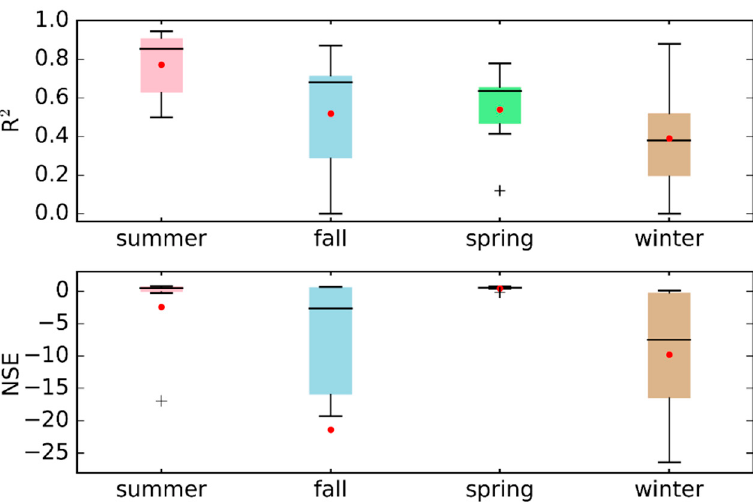
Figure 5. Seasonal NSE and R 2 for the Root River Basin for the calibration period. Average overall NSE and R 2 for the calibration period are 0.69 and 0.70, respectively. The box and whisker plot shows the eight number summary of the performance metrics. The height of the box portion is given by the interquartile range (IQR, 25th to 75th percentile) of the performance metrics NSE and R 2 . The horizontal bar is the median, red dot is the mean and the whiskers represent the 10th and 90th percentile values. The extreme values are shown with a “+”.